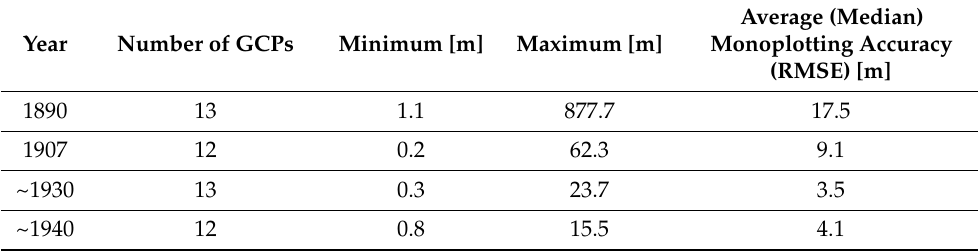
Table 5. Minimum value, maximum value and median of the theoretical 3D error of the corresponding photos: The complete values can be found in Appendix B, Tables A3 and